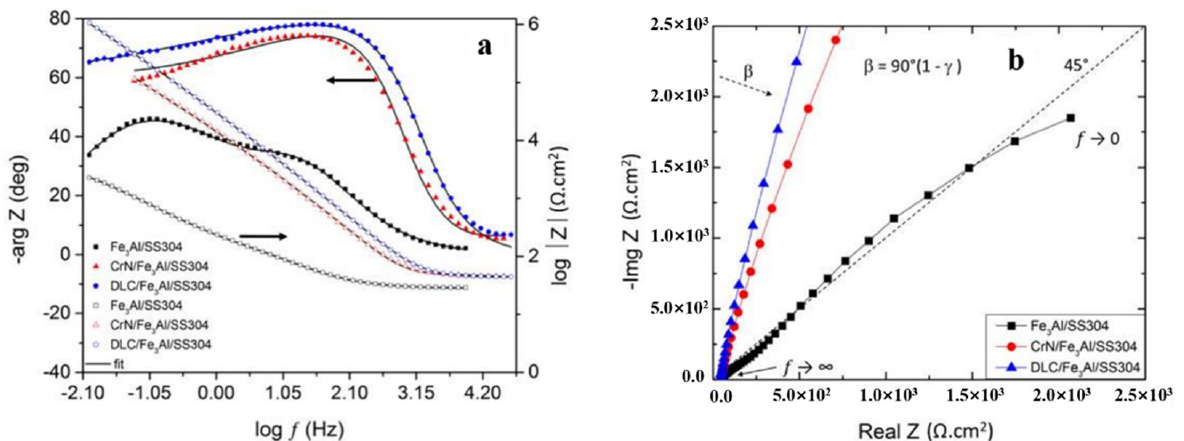
Figure 12. ( a ) Bode and ( b ) Nyquist plots of the Fe3Al, CrN/Fe3Al/SS304 and DLC/Fe3Al/SS304 coatings. Reprinted with permission from Ref. [44]. Copyright Elsevier, 2019.